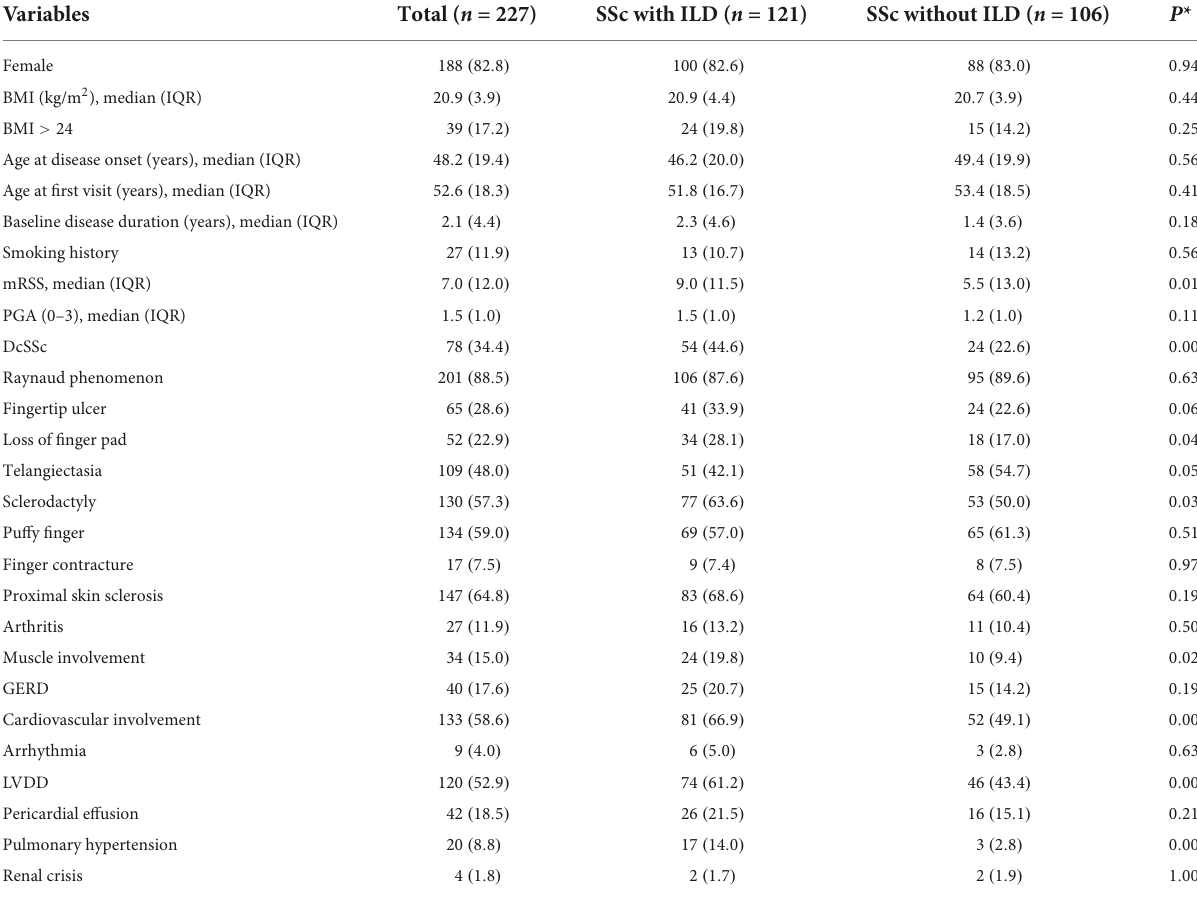
TABLE 1 Comparison of baselines demographics and clinical features between systemic sclerosis with or without interstitial lung disease. Variables Total ( n =